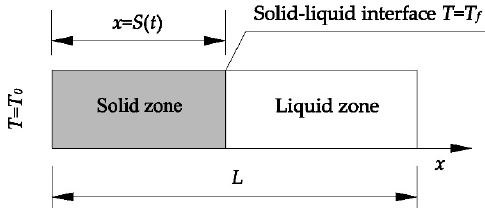
Figure 2 . Flowchart of program realization for soil freezing.